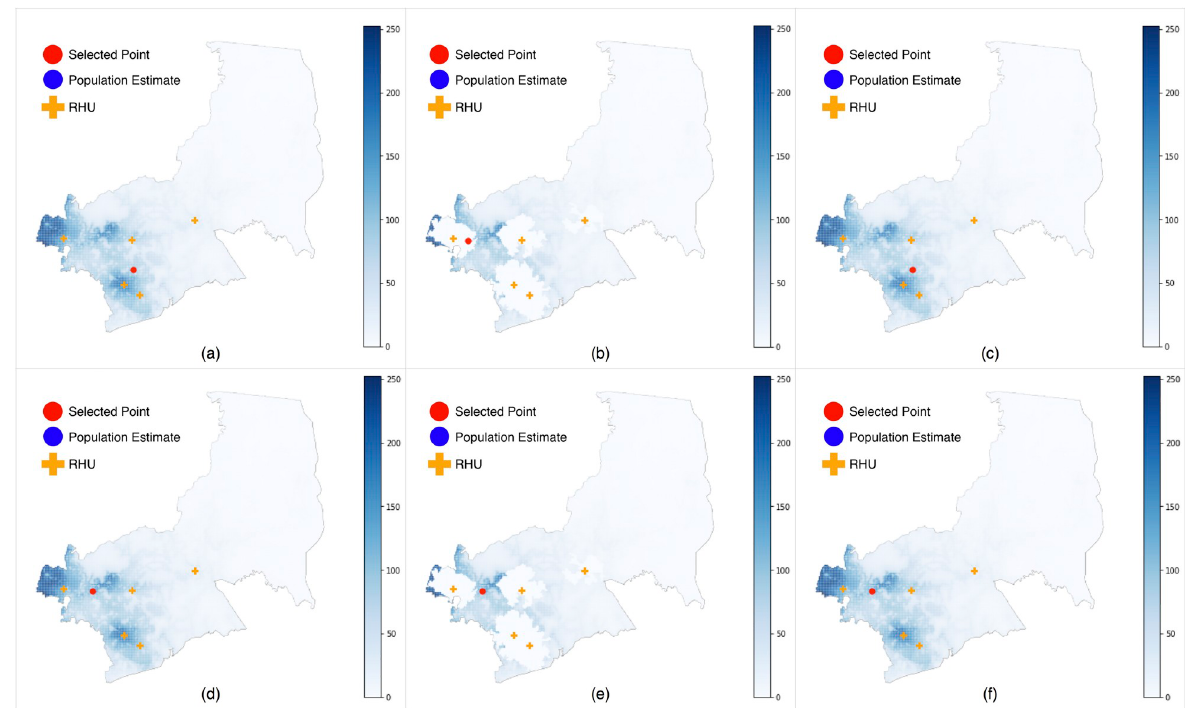
Fig 2. Optimized locations for 1 RHU in Antipolo City. (a) Metric 1, No demand adjustment, Buliran Rd, Brgy. San Luis (Near Philippine Intl. College), (b) Metric 1, Method A, Sumulong Hwy, Brgy. Mambugan, (Near Mambugan Brgy. Hall), (c) Metric 1, Method B, Magsaysay Ave, Brgy. Dela Paz, (Near Robinsons Place Antipolo), (d) Metric 2, No demand adjustment, Sumulong Hwy, Brgy. Santa Cruz, (Near Town and Country Estates), (e) Metric 1, Method A, Sumulong Hwy, Brgy. Santa Cruz, (Near Town and Country Estates), (f) Metric 1, Method B, Sumulong Hwy, Brgy. Santa Cruz, (Near Town and Country